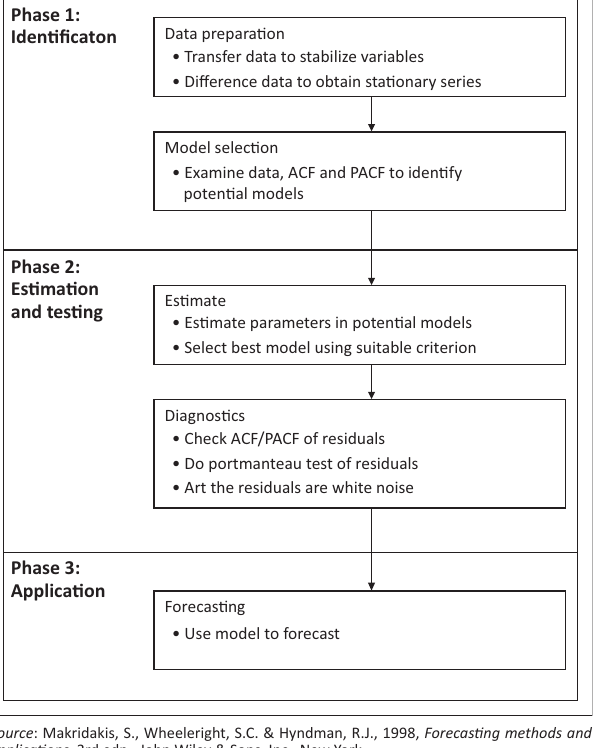
FIGURE 2: Schematic representation of the Box–Jenkins methodology for time series modelling.